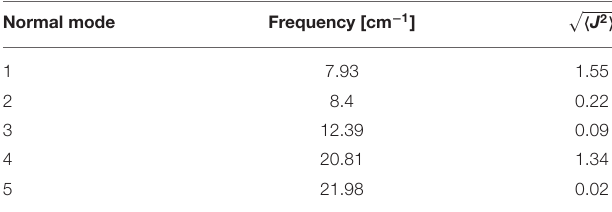
TABLE 2 | Five lowest normal modes and standard deviation of coupling distributions h J 2 i for orthogonal dyad. Normal